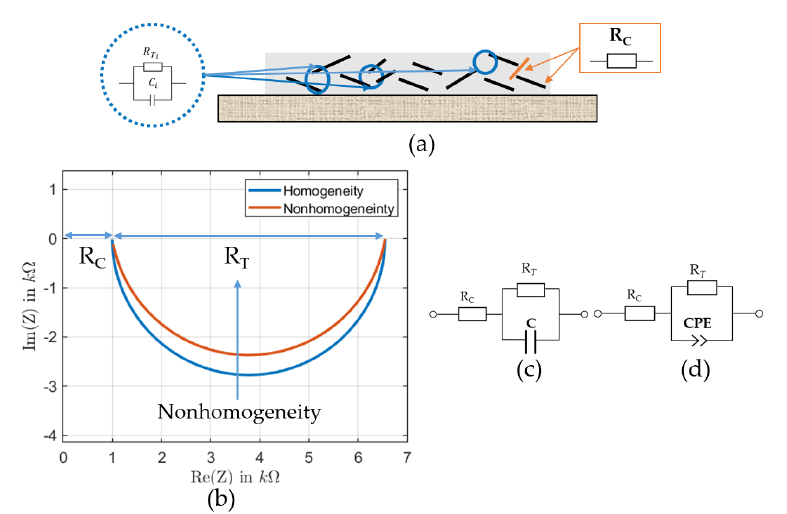
Figure 2. ( a ) Impedance contributions of MWCNTs and MWCNT gaps to the total impedance of the nanocomposite; ( b ) exaggerated behavior of the impedance spectrum of a homogeneous and nonhomogeneous MWCNT nanocomposite; ( c ) equivalent circuit for a homogeneous nanocomposite; ( d ) equivalent circuit for a nonhomogeneous